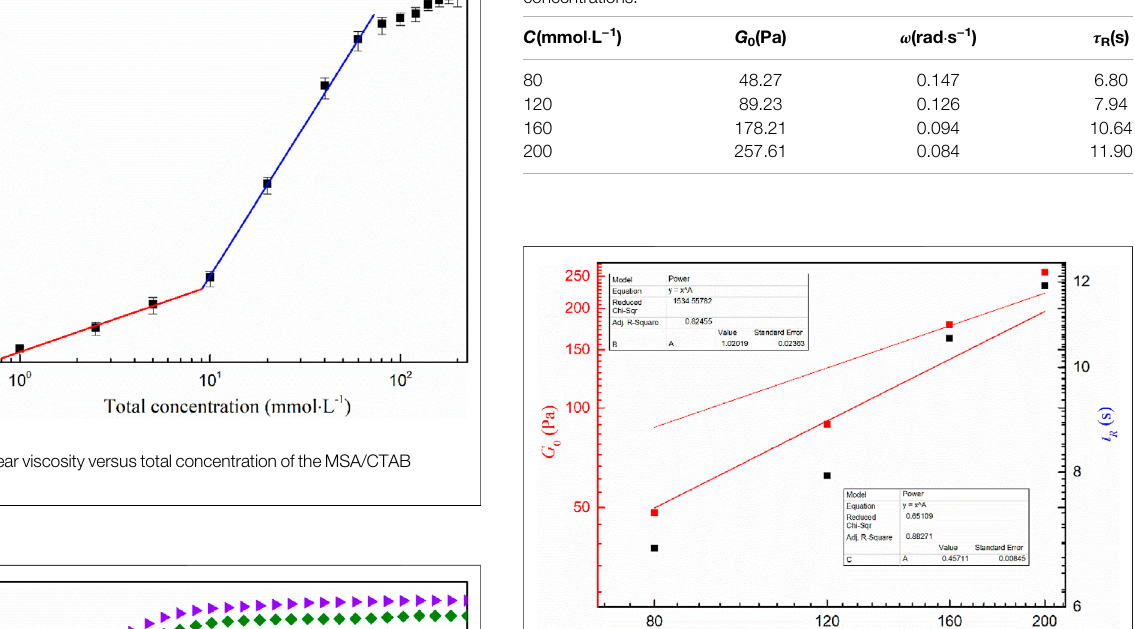
TABLE 1 | Dynamic rheological parameters of the MSA/CTAB system at different concentrations.